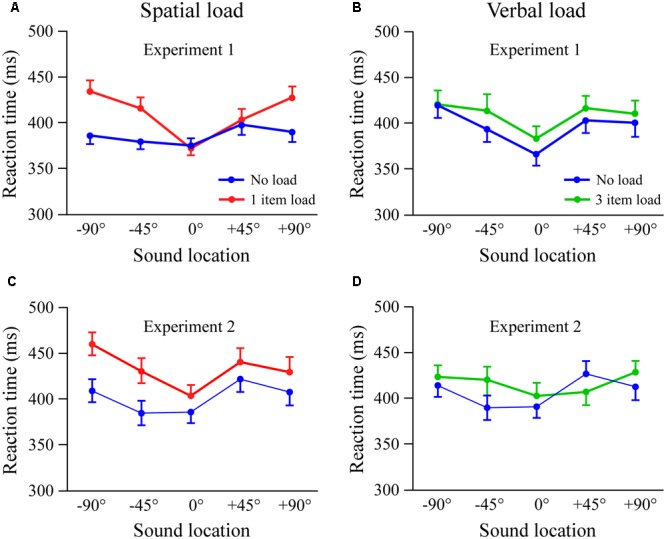
Reaction time as a function of sound location in the spatial (A,C) and verbal (B,D) load conditions. The first row shows data from Experiment 1 (between subject design), while the second row shows results from Experiment 2 (within subject design). The standard location, where most stimuli originated (p = 0.84), is at 0°. Error bars indicate 1 SEM.